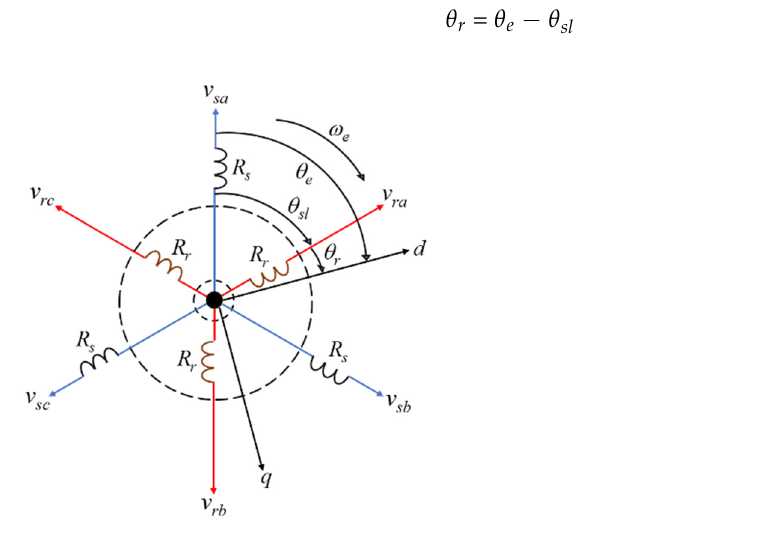
Figure 1. Space vector of ideal three-phase induction motor.